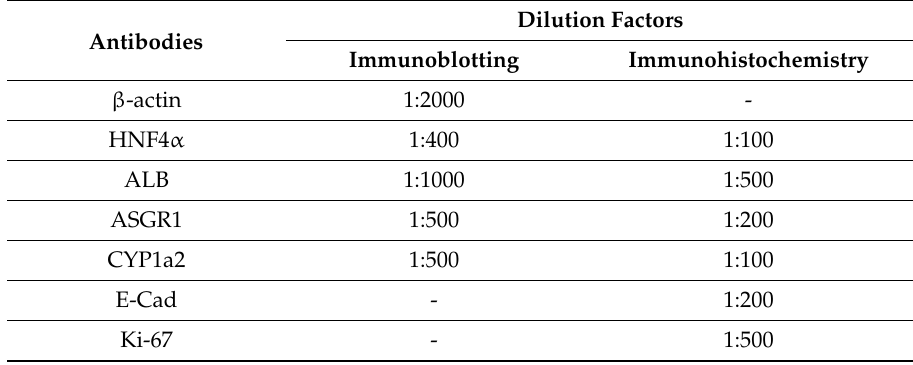
Table 1. List of primary antibodies used for immunoblotting assay and immunohistochemistry. Antibodies